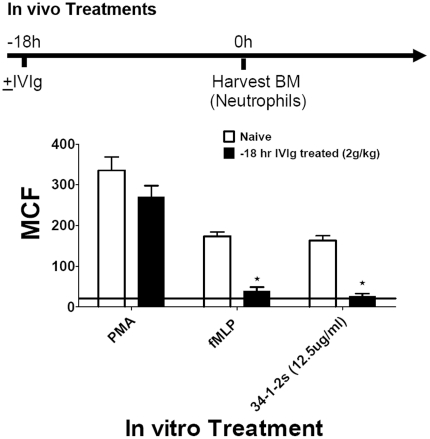
IVIg prevents in vitro stimulated ROS production in SCID mice.The effect of in vivo IVIg treatment on neutrophil ROS production stimulated in vitro. Mice were either not treated (White bars) or treated with 2 g/kg IVIg (Black bars) and their neutrophils were purified and tested for their ability to produce ROS in vitro after stimulation with 34-1-2s, fMLP or PMA. Results are expressed as mean channel fluorescence of DHR-123 fluorescence (±SEM) from 5 mice per group. The horizontal line represents baseline ROS production in non-stimulated neutrophils from naïve SCID mice. The time line at the top demonstrates the protocol timing. The ★ indicates significance (p<0.05) between non-treated and IVIg treated mice in each stimulation and determined by student's t test.